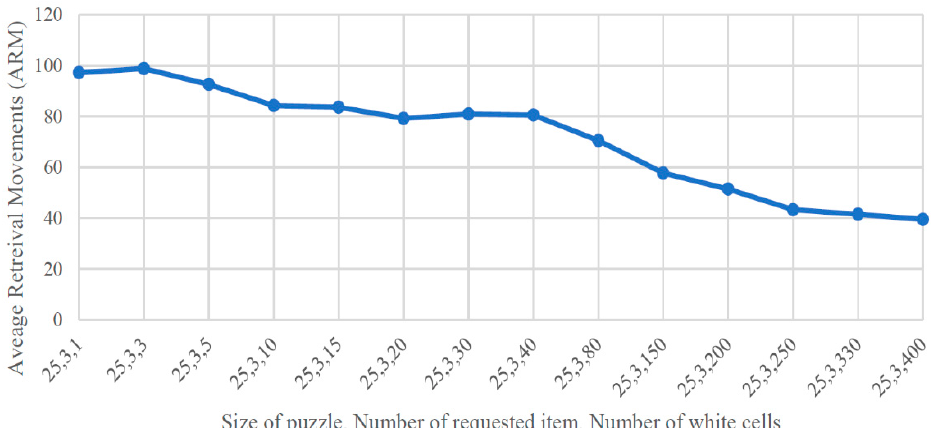
Figure 17. The effect of the number of white cells on the ARM in a 20 × 20 puzzle.